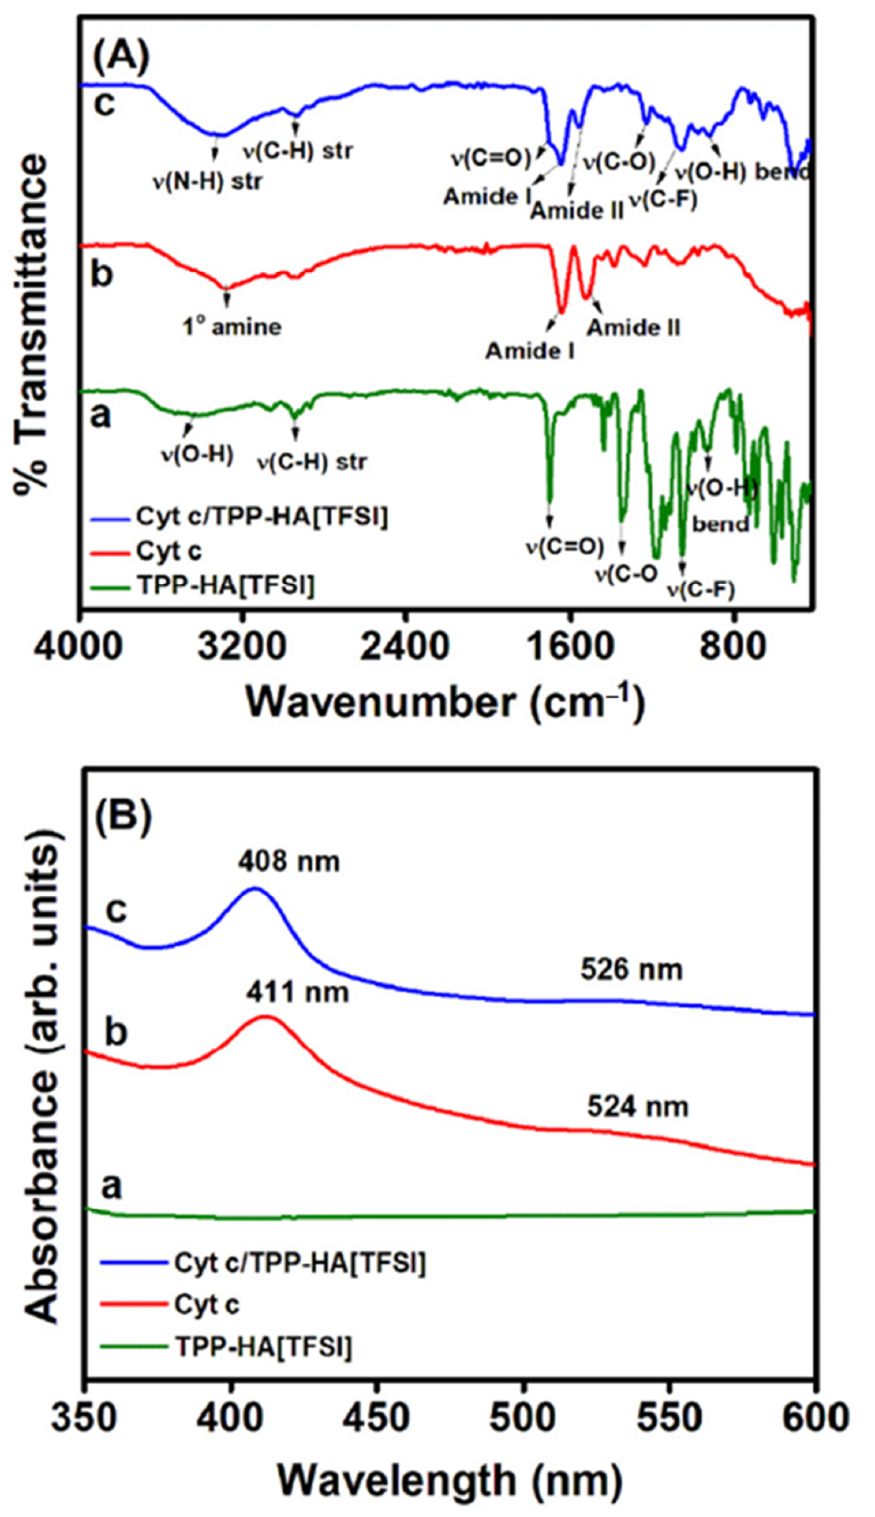
Figure 4. Comparison of ( A ) FTIR and ( B ) UV-Visible spectra of cytochrome c (b) in solution and (c) covalently attached onto a carboxylated ionic liquid (triphenylphosphonium bis ((trifluoromethyl)sulfonyl) amide, TPP-HA[TFSI]). The spectroscopic characterization of the ionic liquid (a) is also shown. Reprinted from Murphy et al. [66], Copyright (2019), with permission from